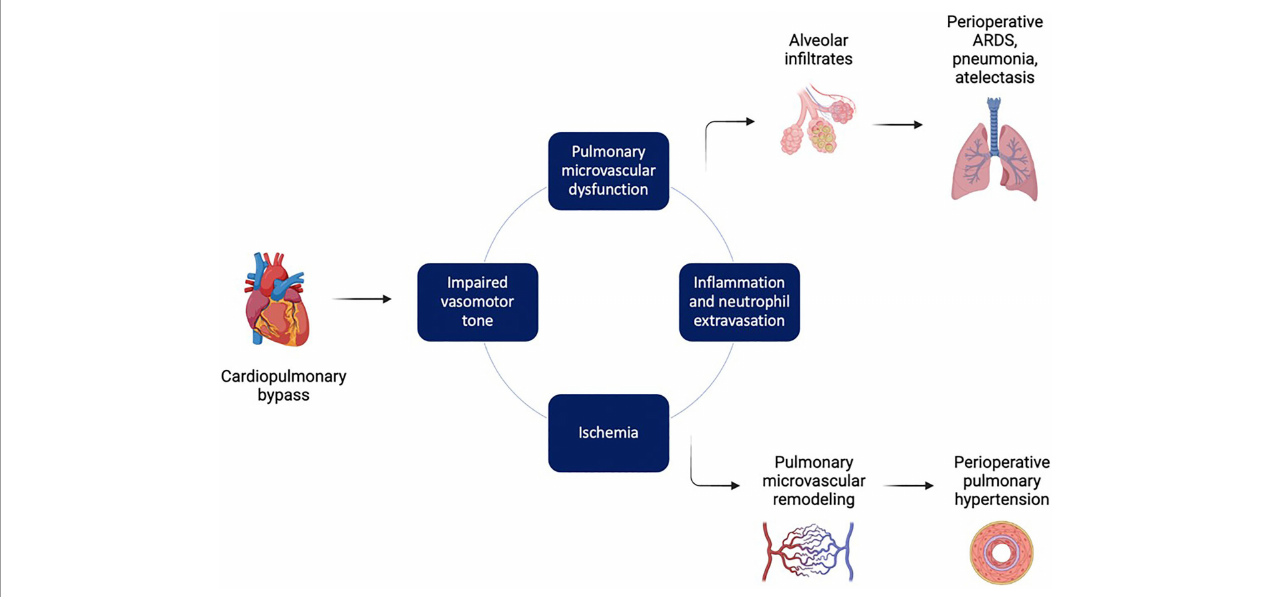
FIGURE5 Factors leading to pulmonary injury during and after cardiopulmonary bypass. Cardiopulmonary bypass (CPB) triggers a pathological series of impaired vasomotor tone, ischemia, and inflammation that drives pulmonary microvascular dysfunction. This in turn can lead to disruption of the alveolar-capillary membranes, pulmonary edema, acute respiratory distress syndrome (ARDS), and atelectasis. In addition, pathologic pulmonary microvascular remodeling can lead to postoperative pulmonary hypertension. Figure created using